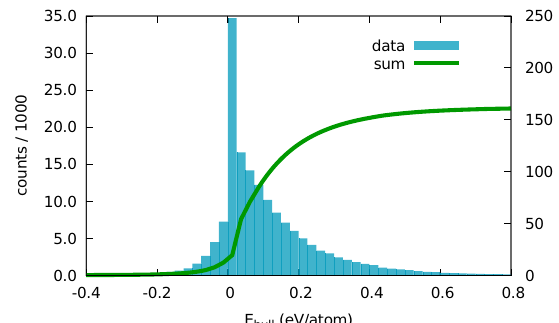
Fig. 1 Thermodynamic stability. Distribution of the distances to the convex hull of all 189,981